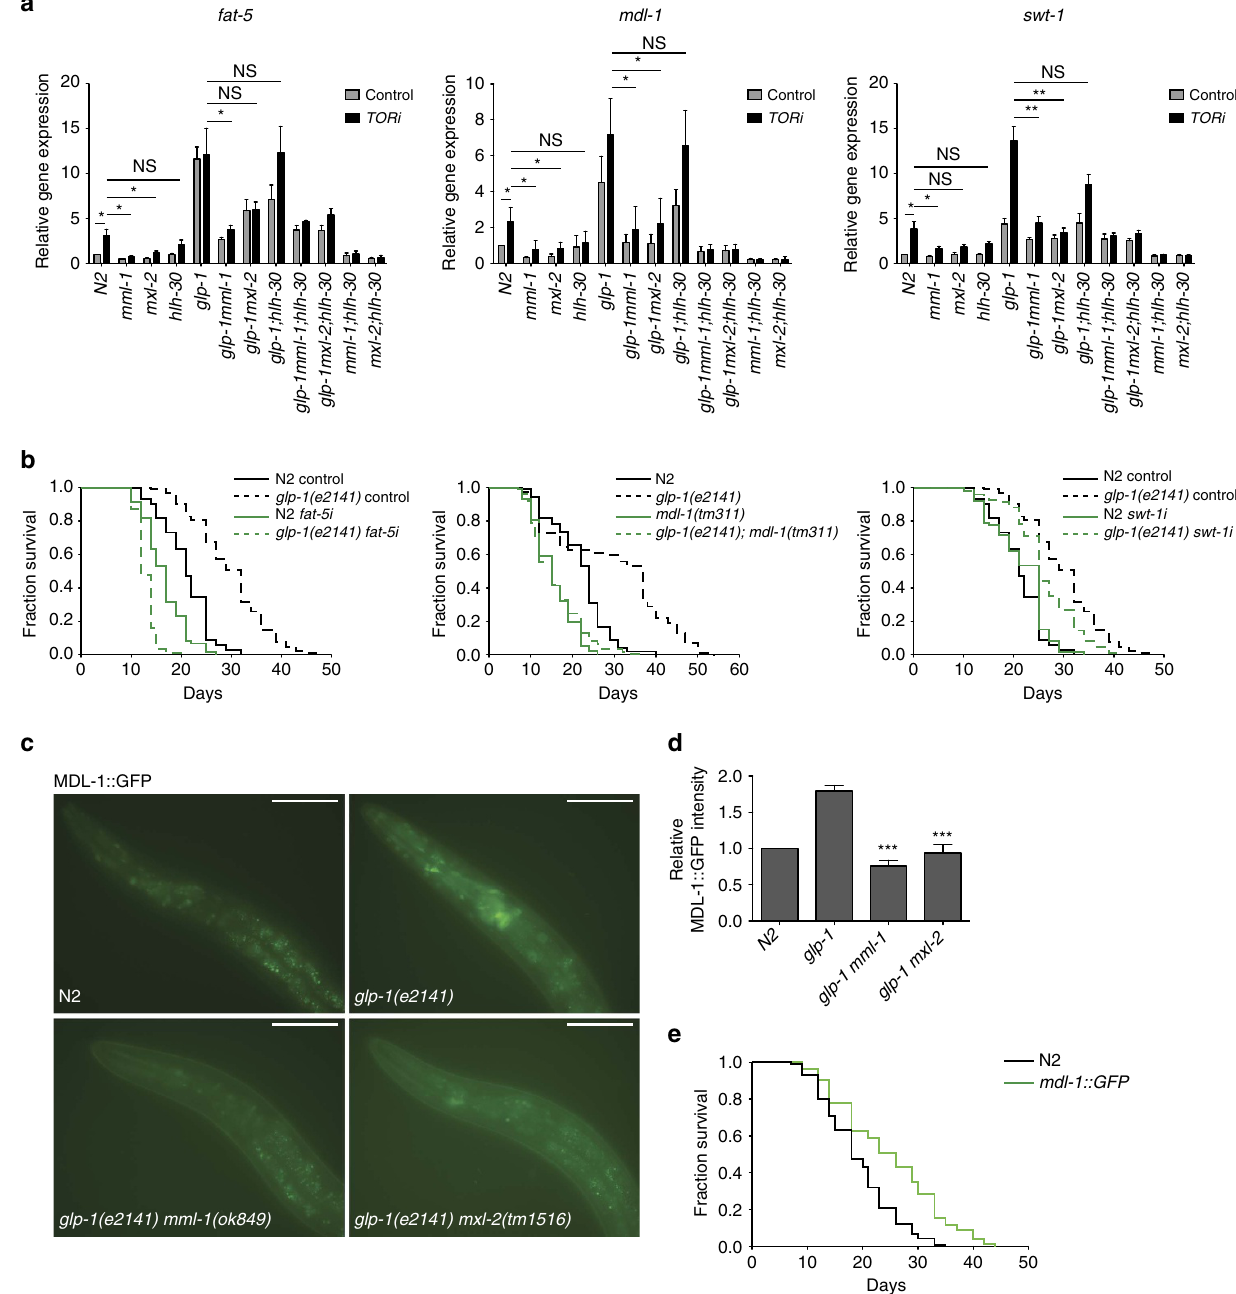
Figure 7 | MML-1/MXL-2 preferentially regulated genes contribute to gonadal longevity. ( a ) qRT–PCR analysis of MML-1/MXL-2 preferentially regulated genes after treatment with control or TOR RNAi. The bar represents mean ± s.e.m. from three biological replicates relative to N2. P -value (* P o 0.05 and ** P o 0.01) was determined by one-way analysis of variance (ANOVA) with Tukey’s test. ( b ) Knockdown of fat-5 , mdl-1 and swt-1 significantly suppress glp-1 longevity. ( c ) Representative fluorescent images of MDL-1::GFP in indicated strains at day 1 adult. Upregulation of MDL-1::GFP in glp-1 background is abolished by mml-1 or mxl-2 deletion. ( d ) Quantification of MDL-1::GFP in the head region in indicated genotypes. Bars indicate mean ± s.e.m. from 3 biological replicates ( 4 20 worms each). P -value (*** P o 0.001) was determined by t -test. ( e ) MDL-1 overexpression extends wild- type lifespan. Scale bars, 50 m m ( c